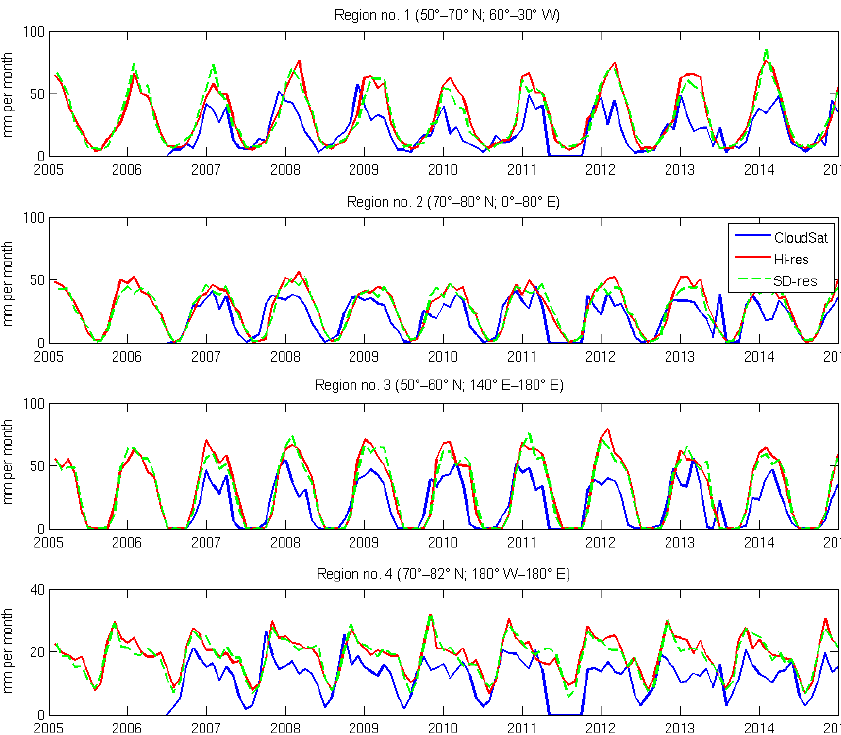
Figure 6. Time series of snowfall (mmmonth − 1 ) for the period 2005–2015 from CloudSat (blue line), Hi-res ensemble model mean (red) and Std-res ensemble model mean (green) over the three regions shown in Fig. 5 and over the whole Arctic.